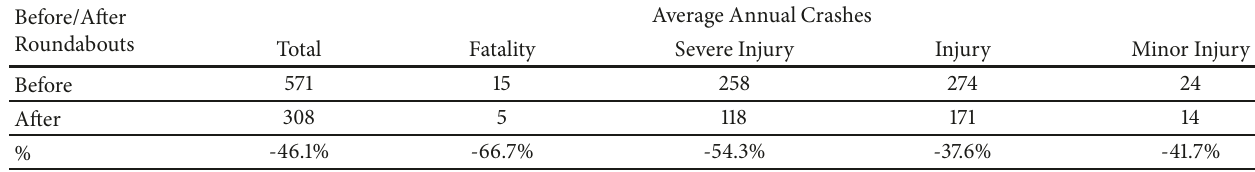
Table 2: Accident reduction effects of roundabout